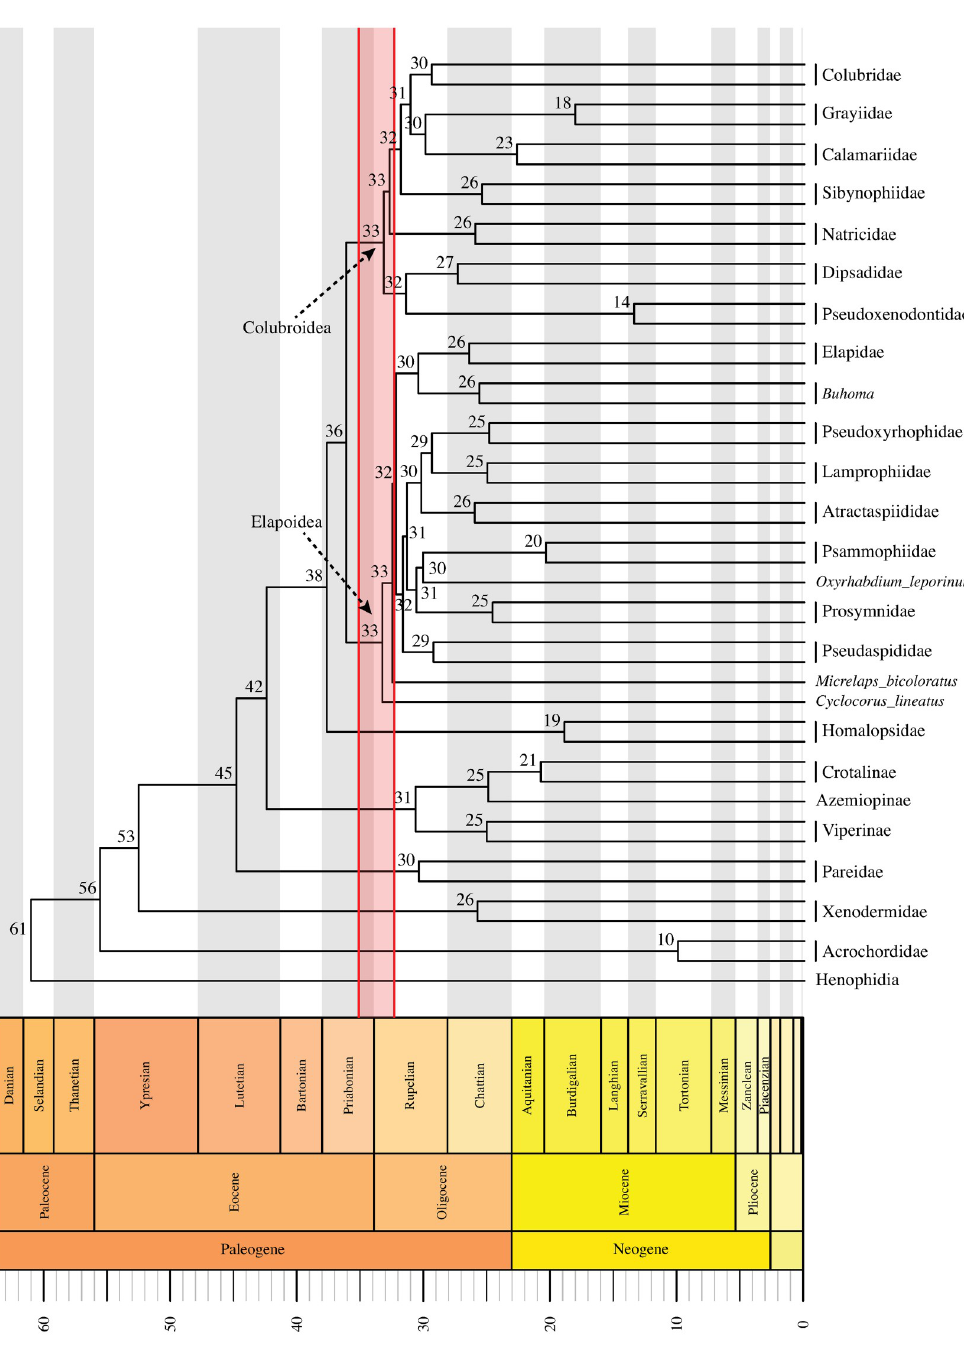
Fig 22. TreePL calibrated tree showing divergence time estimates for the major families of Colubroides. Values above branches represent estimated ages in millions of years. Red-shaded vertical bar corresponds to the possible range of the Eocene–Oligocene interval known as the “Grande